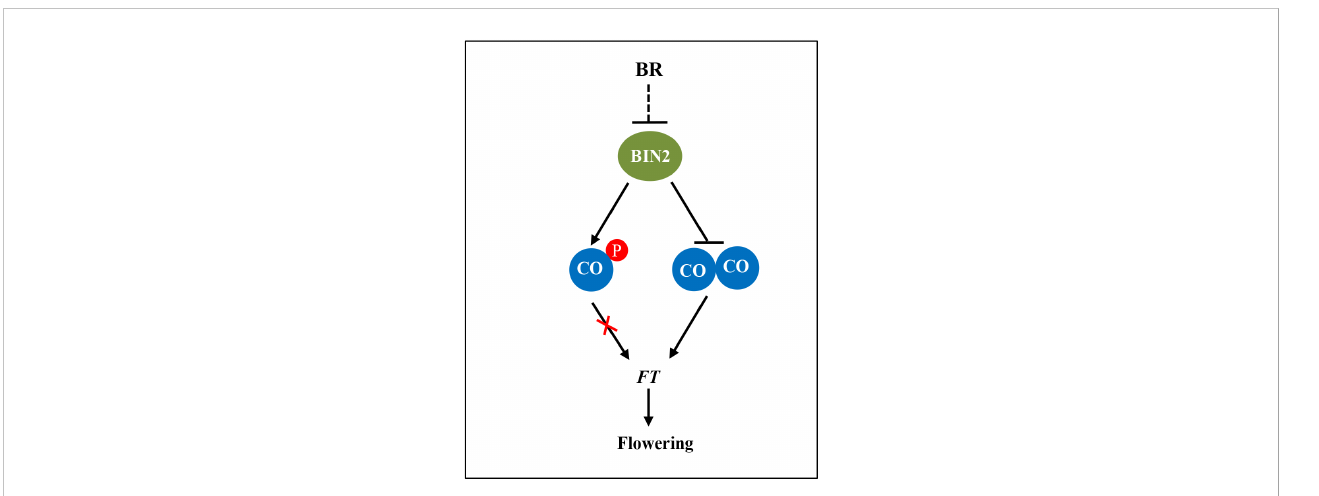
FIGURE 6 A propose working model for the regulation of CO activity by BIN2. The BR signaling repressor BIN2 physically interacts with and phosphorylates CO to inhibit the DNA-binding activity and also prevents the interaction of CO-CO to restrict the function of CO in activating FT